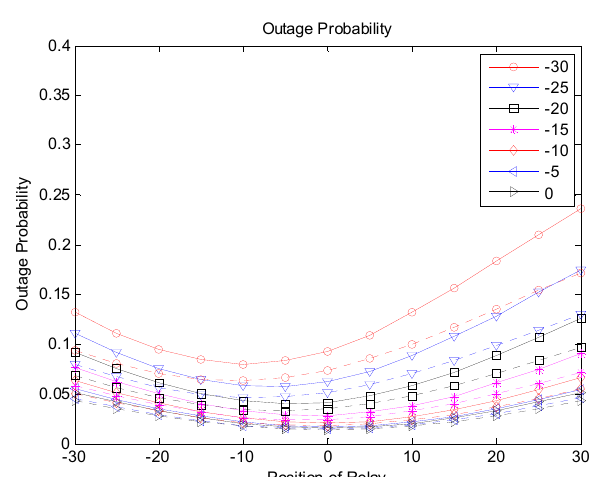
Sensors 2018 , 18 , x FOR PEER REVIEW Figure 10. Outage probability (Scenario 2). Figure 10. Outage probability (Scenario 2). Figure 10. Outage probability (Scenario 2).